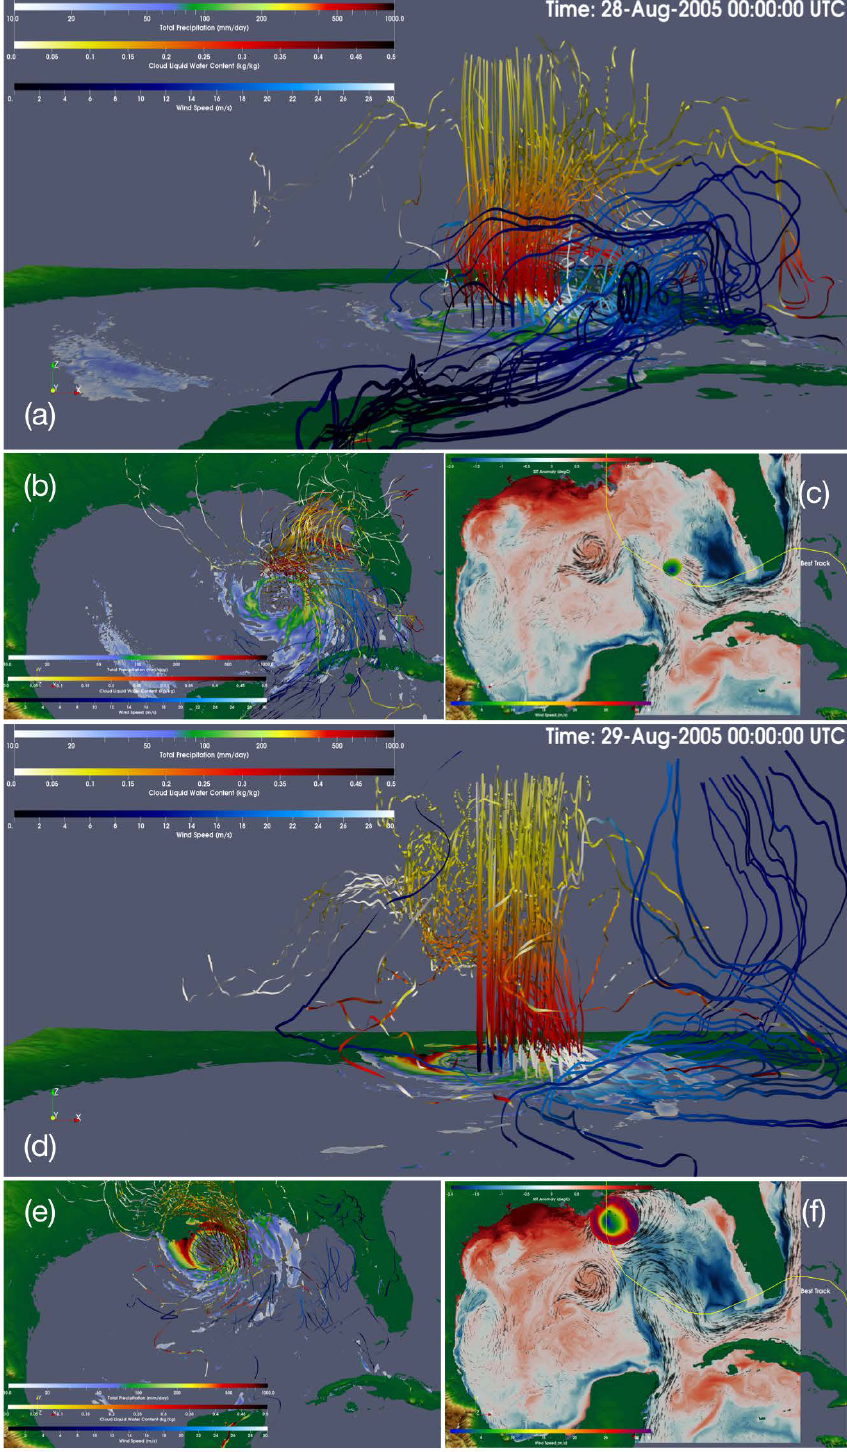
Figure 14. Same as Fig. 13 but for the COP_HR simulation. The larger versions of figures are also given in the Supplement. The comparison of low- and high-resolution model results is shown in the supplemental